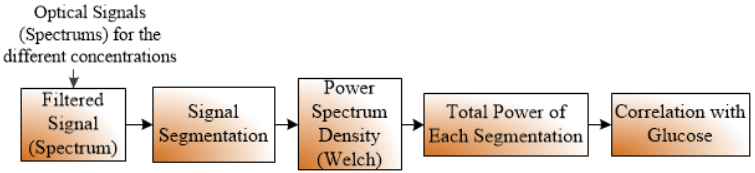
Fig. 2. The proposed power spectral density based algorithm °ow chart.